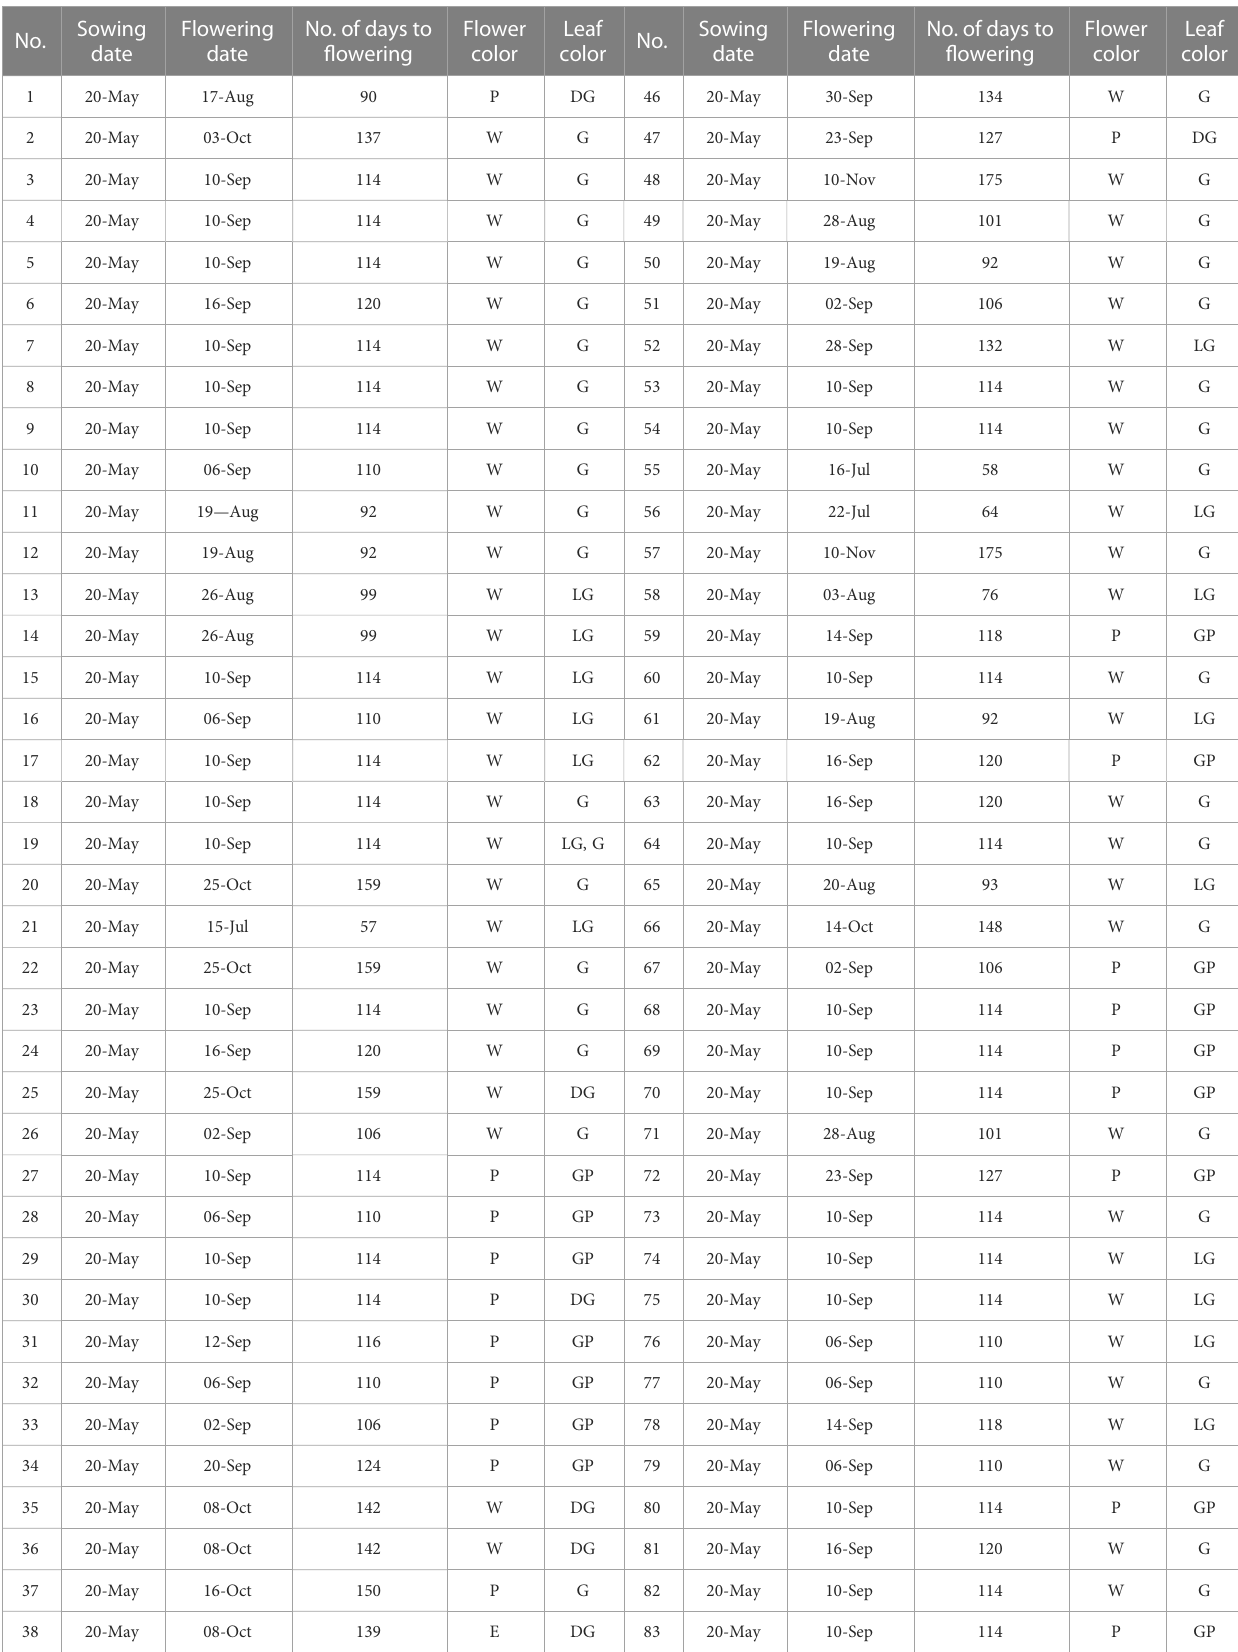
TABLE 1 Characteristics of 90 perilla cultivars or perilla genetic